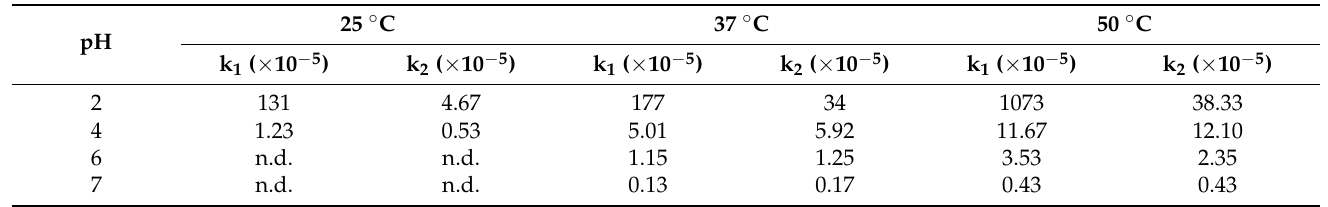
Table 3. Rate constants (s − 1 ) for the hydrolysis of ATP with polyoxovanadates at pH = 2–7 and T = 25 ◦ C, 37 ◦ C and 50 ◦ C 1 .